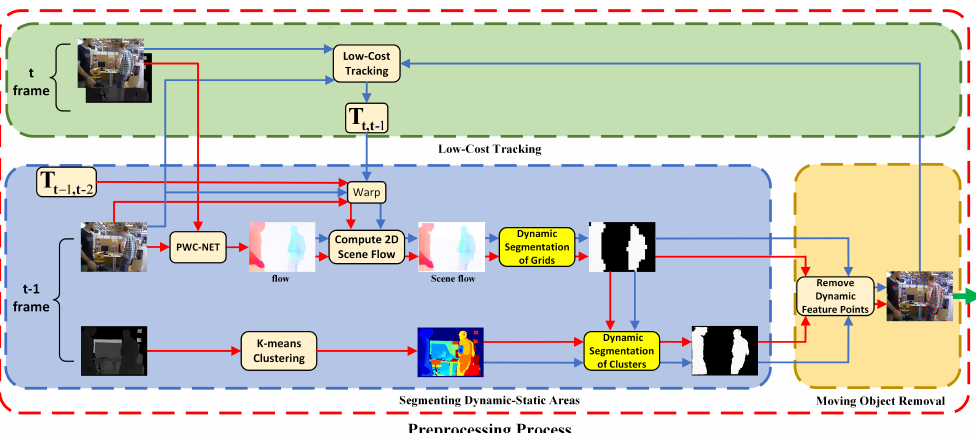
Figure 2. The red dashed line is an overview of the preprocessing process. Different color dashed lines indicate different modules. The blue module is used as the Segmenting Dynamic–Static Areas module to produce a grid segmentation dynamic–static mask image and a k-means clustering segmentation dynamic–static mask image. The yellow module is used as the Moving Object Removal module to remove dynamic keypoints using the two mask images jointly. The green module is used as a Low-Cost Tracking module to calculate rough poses. The blue and yellow modules together form the Motion Removal module in Figure 1, and the green module is the Low-Cost Tracking module in Figure 1. In this figure, we have two iterative processes, the red arrows indicate the first iterative process and the blue arrows indicate the second iterative process. The green arrow indicates the dynamic–static feature points obtained from the preprocessing process are passed to the tracking module. The highlighted parts are grid dynamic–static segmentation and k-means clustering dynamic–static segmentation,